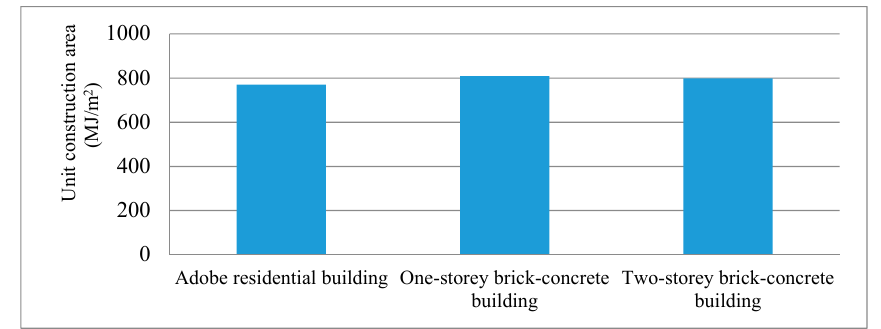
Figure 12. Total energy demand in the process of building demolition.